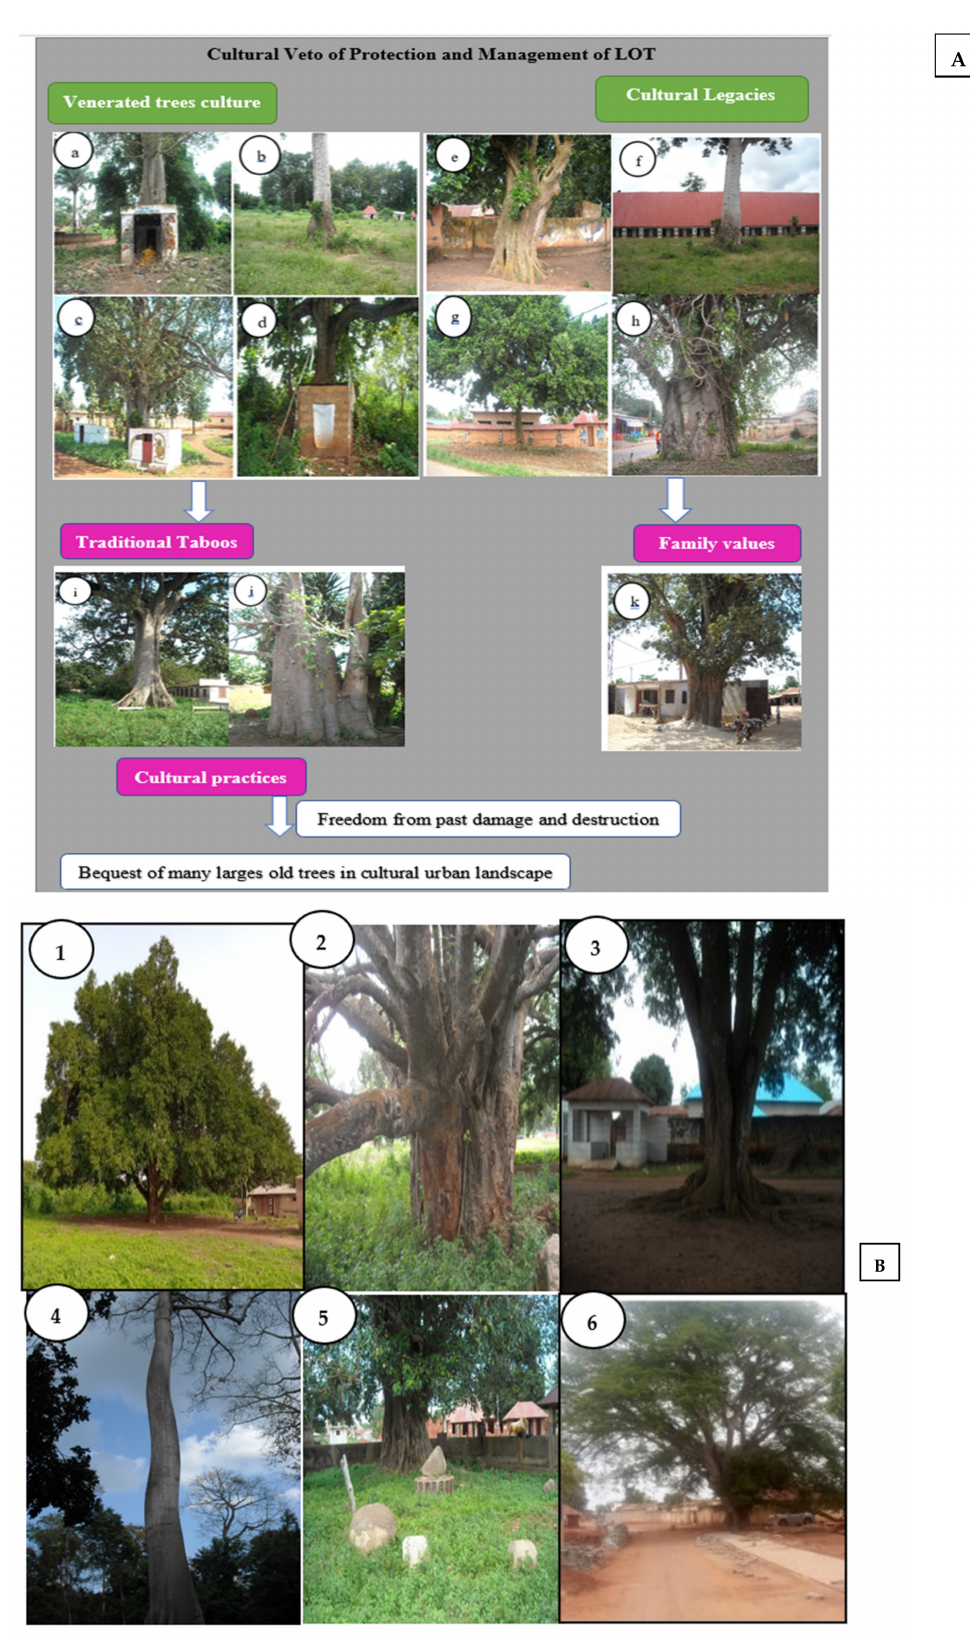
Figure 10. ( A ): Notable cases of local cultures, beliefs, and legends associated with the protection and management of large old trees in the Abomey district. ( a – d ): venerated LOTs (at the feet of